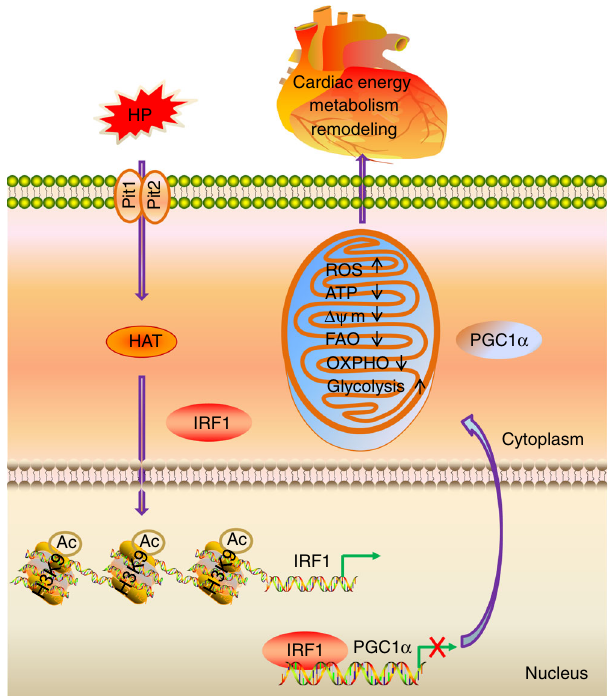
Fig. 9 A proposed model of the mechanism underlying myocardial energy metabolism remodeling and HF induced by HP. High phosphate (HP) enters cardiomyocytes via Pit1 and Pit2, and induces IRF1 expression through acetylating histone H3K9 in the IRF1 promoter region, during which histone acetyltransferases (HAT) are involved. HP-induced IRF1 inhibits PGC1 α expression via directly binding to its promoter region ( − 632 to − 612). PGC1 α downregulation contributes to HP-induced mitochondrial dysfunction and myocardial energy metabolism remodeling. Restoration of PGC1 α expression or knockdown of IRF1 protects against CKD-associated myocardial energy metabolism remodeling and In summary, our fi ndings demonstrated that HP-induced alterations in the IRF1 – PGC1 α signaling pathway had an important role in the pathogenesis of CRS4 and restoration of PGC1 α expression or knockdown of IRF1 improved energy metabolic dysfunction and HF under uremic milieu. Our study suggests that control of hyperphosphatemia or targeted inter- vention on HP-mediated IRF1 elevation and PGC1 α down- regulation could be a potential therapy for reducing the risk of cardiovascular death in CKD patients.